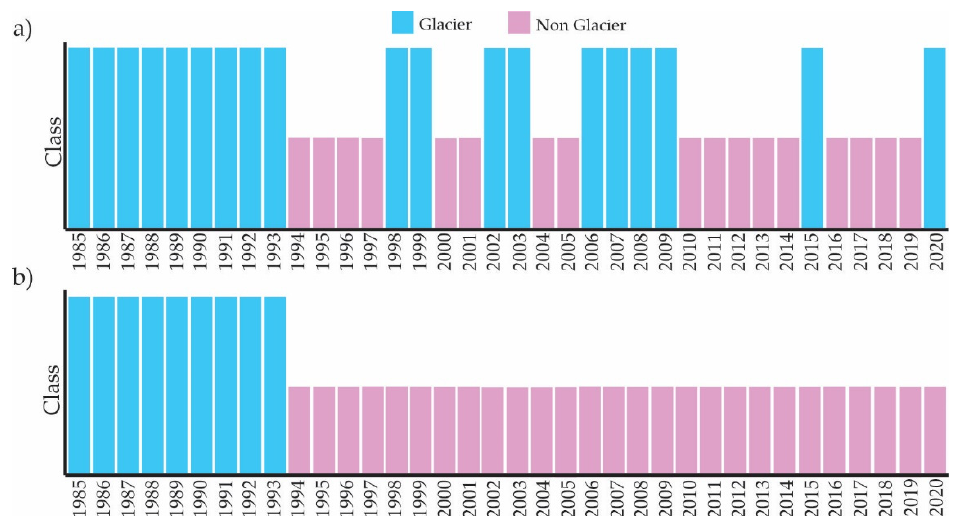
Figure 9. Example of the temporal permanence filter application: ( a ) time series of the original classification, and ( b ) time series of the filtered classification.